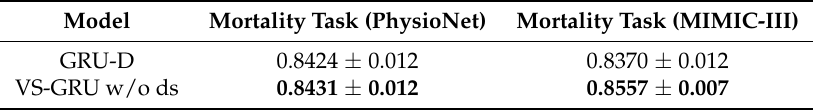
Table 7. Comparison on deep supervision in a single